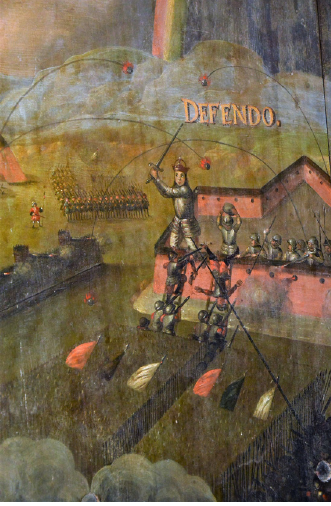
Figure 14 The landlord: